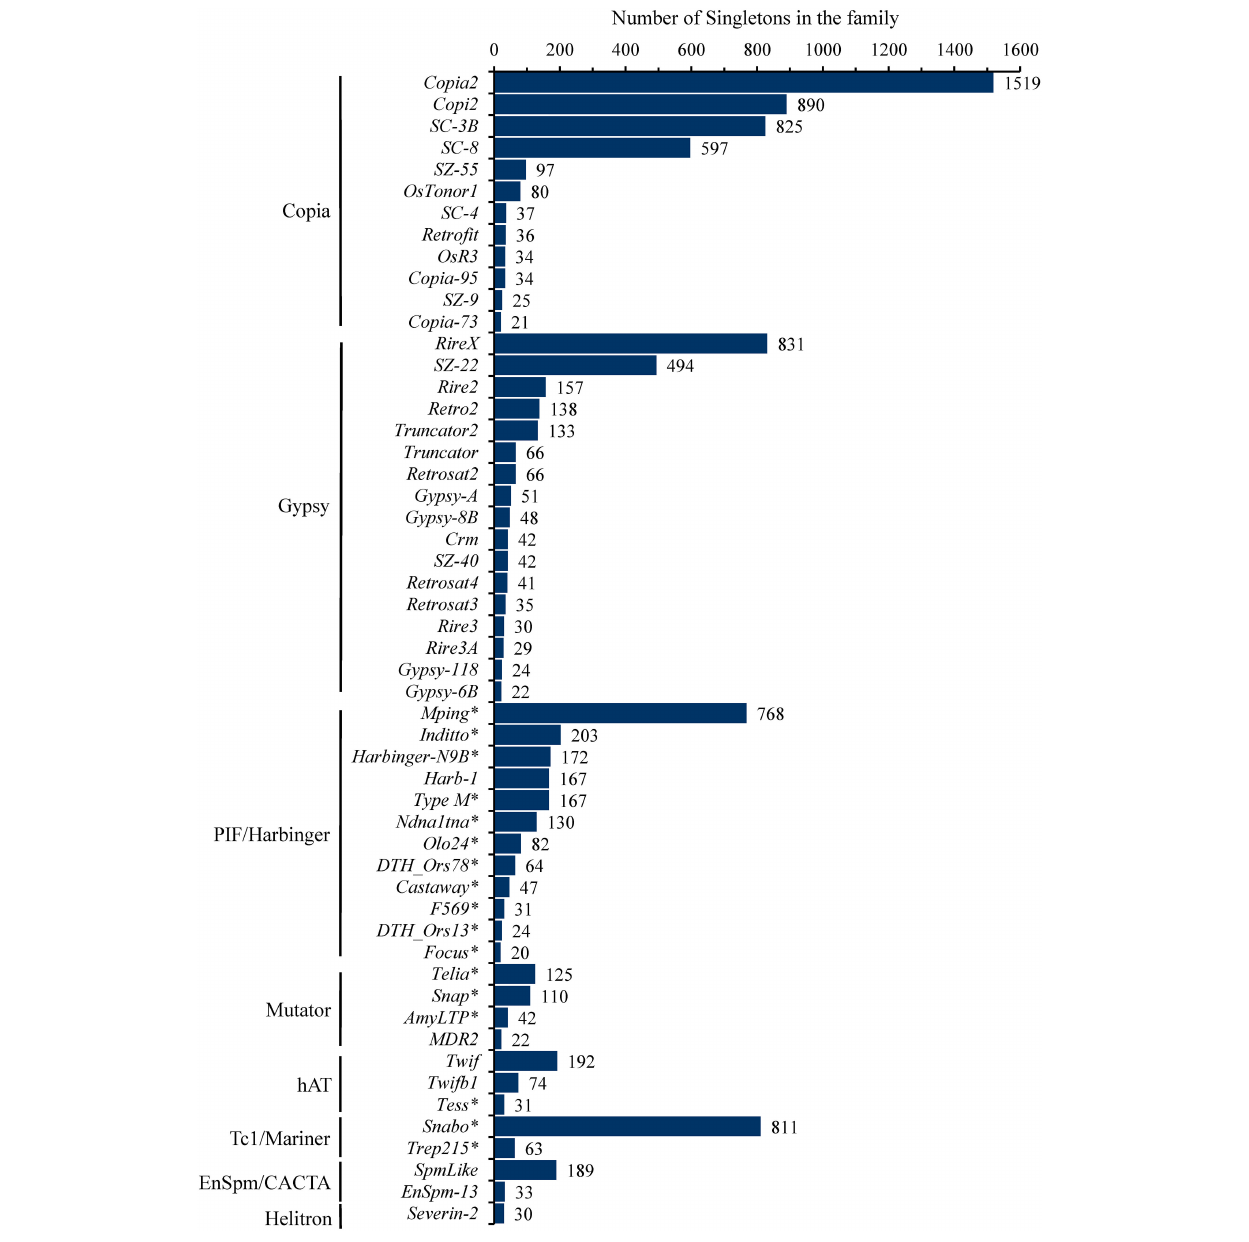
retrotransposons than from DNA transposons (6,735 versus 4,189) ( Table 1 ). All 11 TE superfamilies were identified in our dataset ( Table 1 ), but the number of singletons varied substantially across different superfamilies, implying distinct current activity. The loci of Copia were approximately twice more than Gypsy (4,307 versus 2,390; Table 1 ) despite that both belong to LTR type. For TIR elements, PIF/Harbinger exhibited